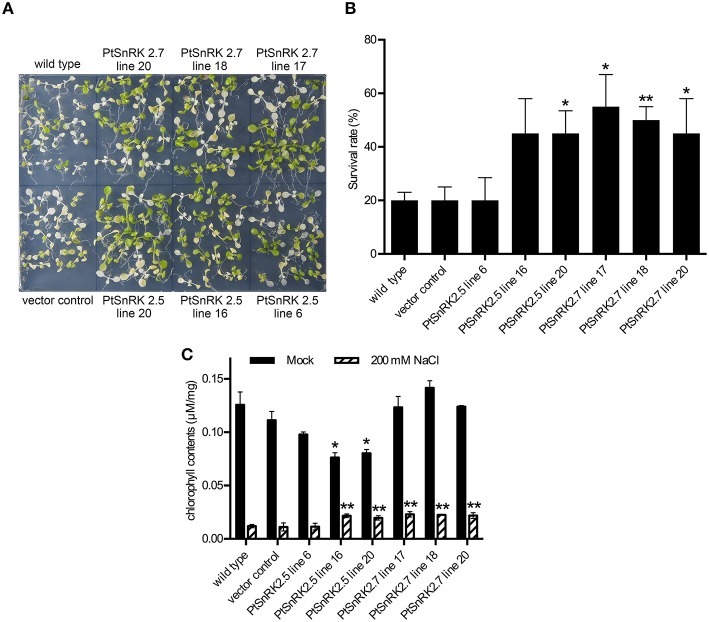
High salinity tolerance phenotype of transgenic Arabidopsis overexpressing PtSnRK2.5 and PtSnRK7. (A) Seedlings of the wild-type, vector control, and overexpressors of PtSnRK2.5 and PtSnRK2.7 treated with 200 mM NaCl for 4 days. (B) Survival rates determined by observations after a 4-day salt stress treatment. The green seedlings were counted as living seedlings, and the percentages of live seedlings were calculated using 20 seedlings for each line. (C) Chlorophyll contents determined from 20 seedlings after a 4-day salt stress treatment. Results are means ± SE (n = 3). Asterisks indicate statistically significant differences between transgenic and wild-type plants (Student's t-test; *p < 0.05; **p < 0.01).